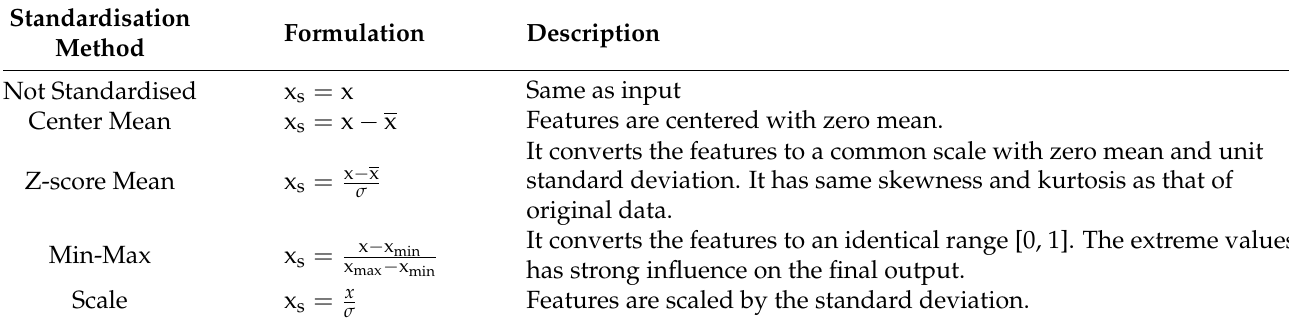
Table 2. Different scaling methods and their